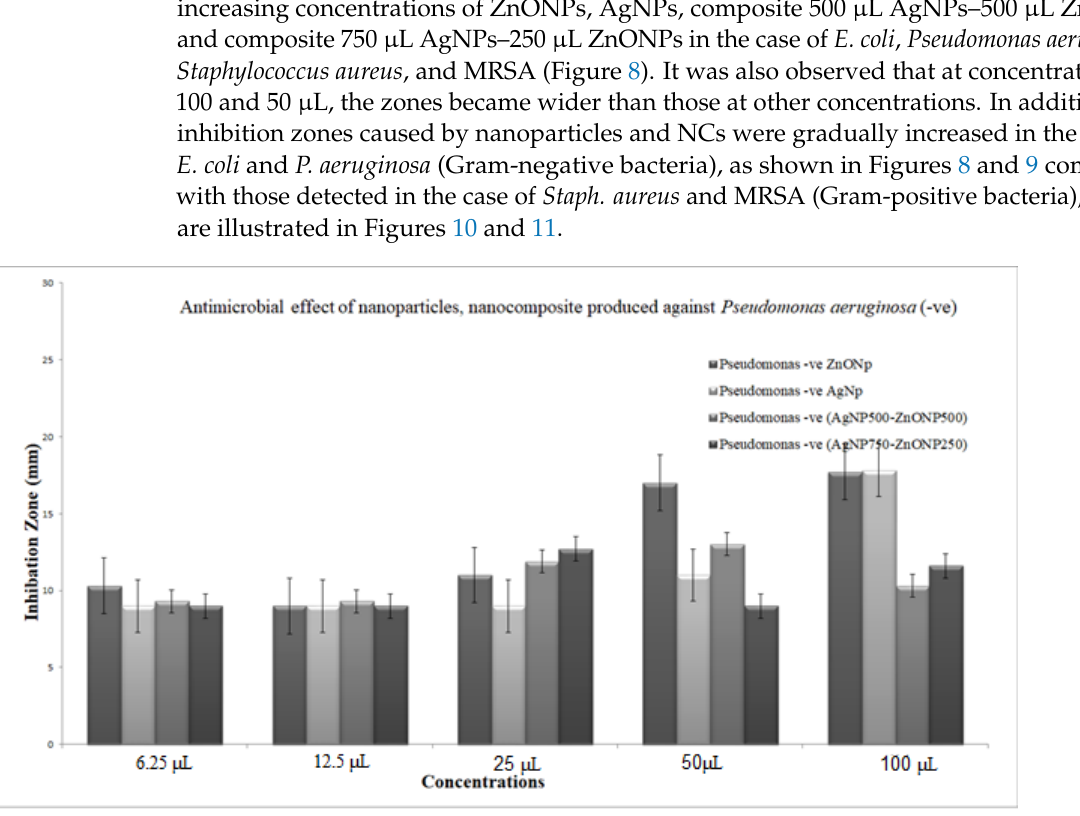
Figure 8. The antimicrobial activity of the nanoparticles and nanocomposite produced against Pseudomonas aeruginosa showing increasing inhibition zone with increasing amounts of nanoparticles: 6.25, 12.5, 25, 50 and 100 µ L with volume made up to 100 µ L with distilled water wherever needed. Zinc oxide nanoparticles (ZnONPs); silver nanoparticles (AgNPs); composite 500 µ L AgNPs–500 µ L ZnONPs; composite 750 µ L AgNPs–250 µ L ZnONPs nanoparticles. SD ± , standard deviation.